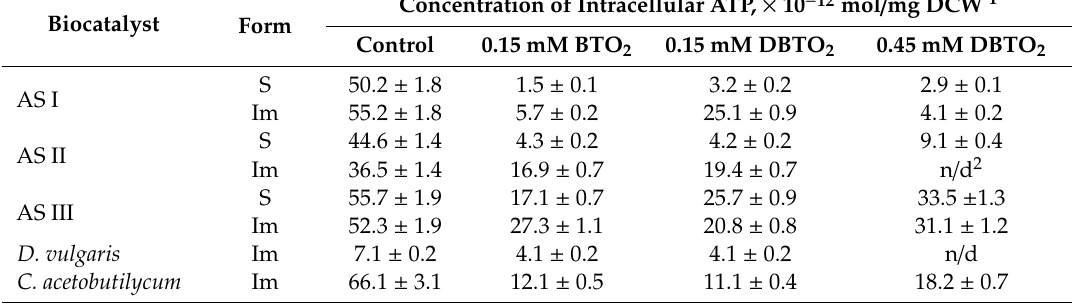
Table 3. Concentration of intracellular ATP in anaerobic cells before (control) and after their usage in sulfones bioconversion for 18